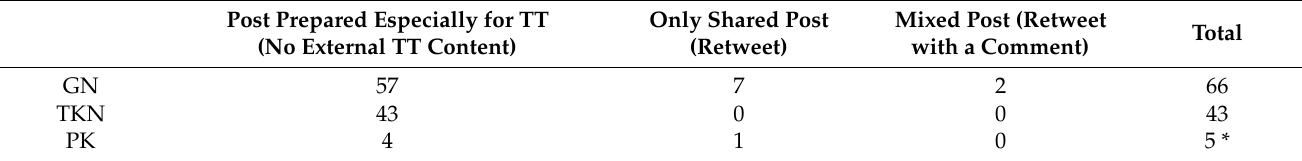
Table 8. Post preparation (N =